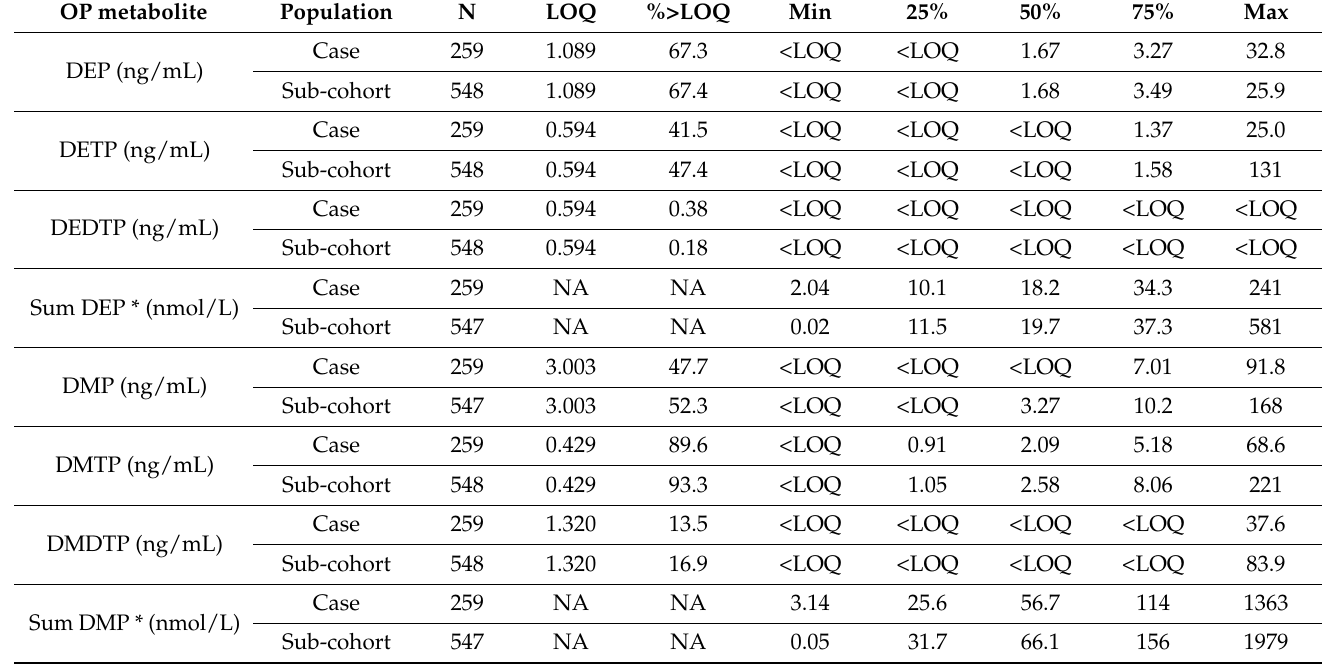
Table 3. Prenatal urinary organophosphorus-pesticide metabolite concentration distribution in a nested case–cohort study of preschool attention-deficit hyperactivity disorder in the Norwegian Mother and Child Cohort (MoBa), birth years